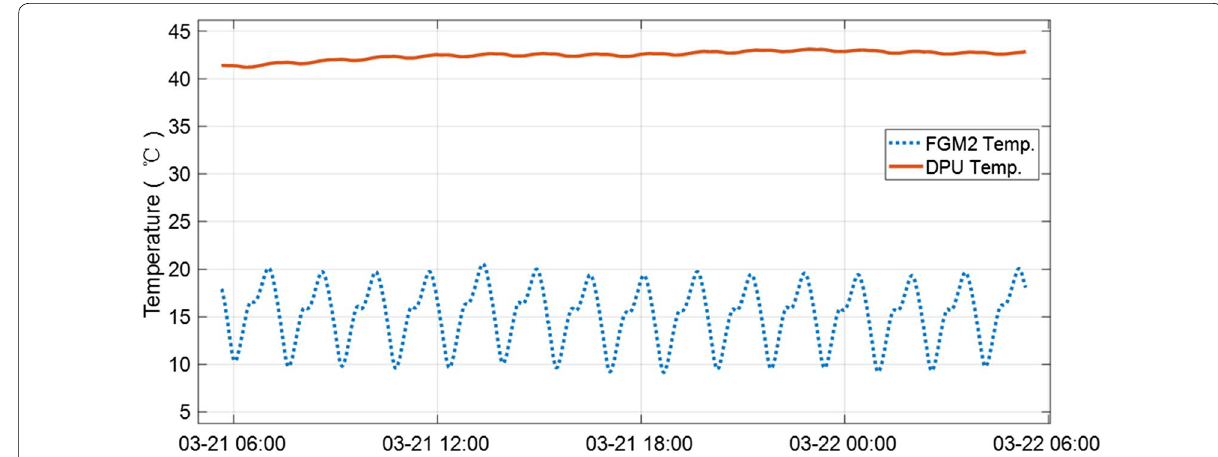
Fig. 10 DCU and FGM2 sensor temperature variations in-orbit